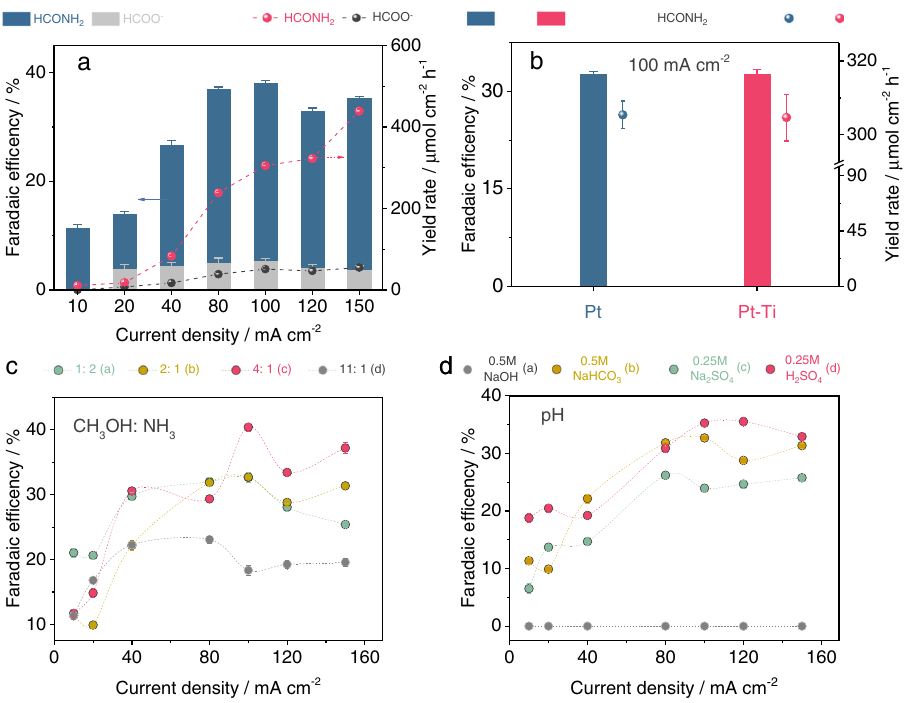
Fig. 2 | Formamide electrosynthesis from methanol and ammonia oxidation. a TheoptimizationofthecurrentdensitiesoverPtforformamideelectrosynthesis. b Formamide electrosynthesis performance over Pt and Pt-Ti at 100mAcm − 2 . The